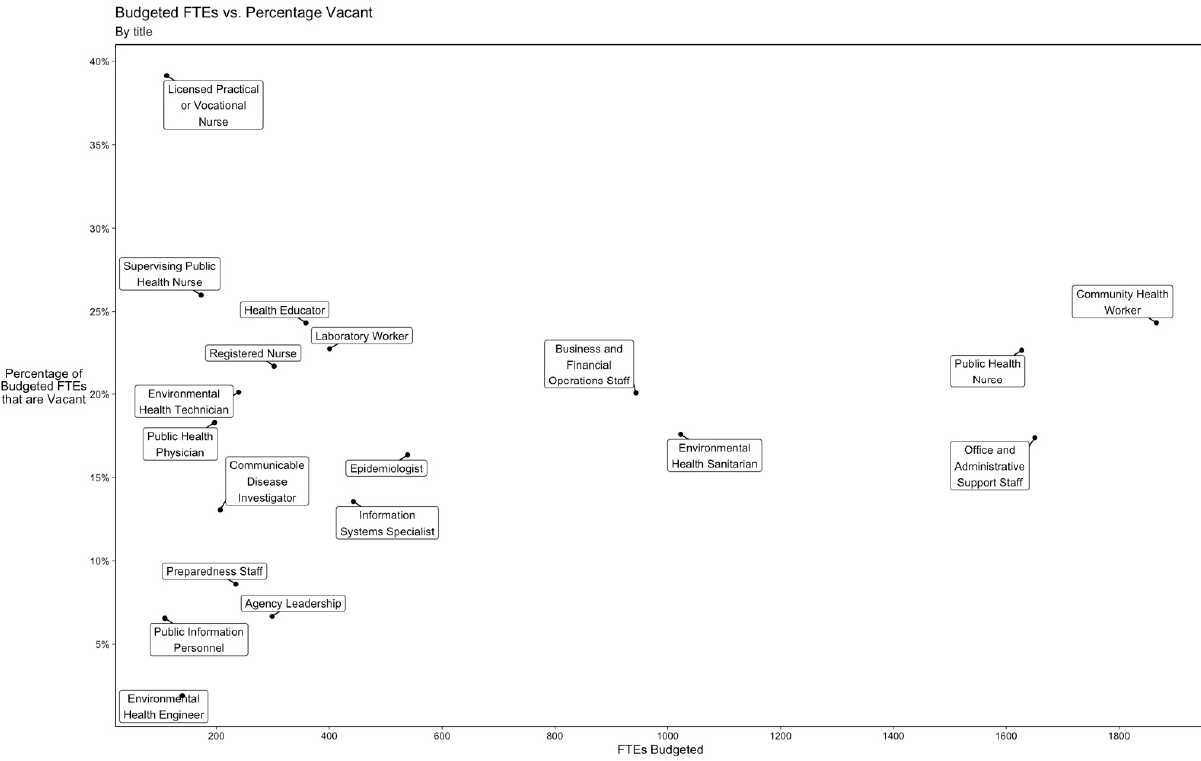
Figure 3. Budgeted FTEs vs. Vacancy Rate Among LHDs in NYS (2021), by Occupational Title. Inverse probability weighting is applied to adjust for nonparticipation.